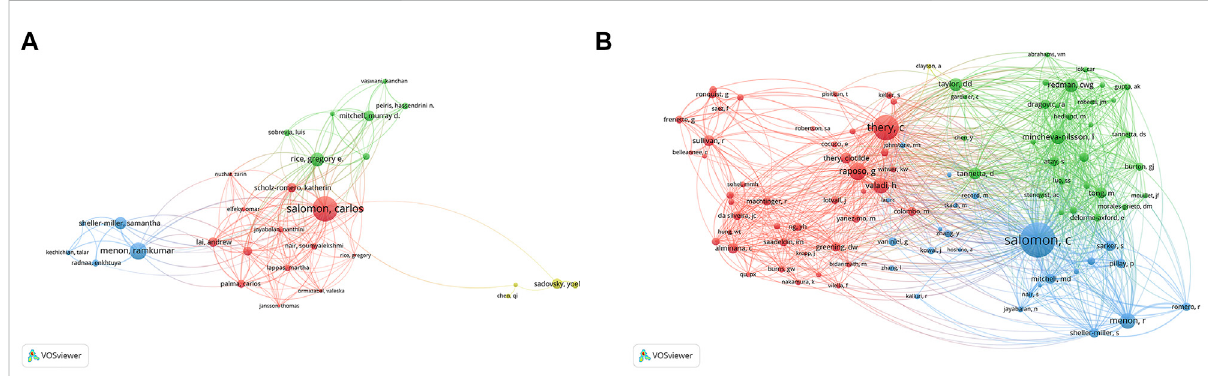
FIGURE 5 The distribution of authors publishing research on exosomes in reproduction. (A) Collaboration network among the authors. (B) co-citations network among the authors.